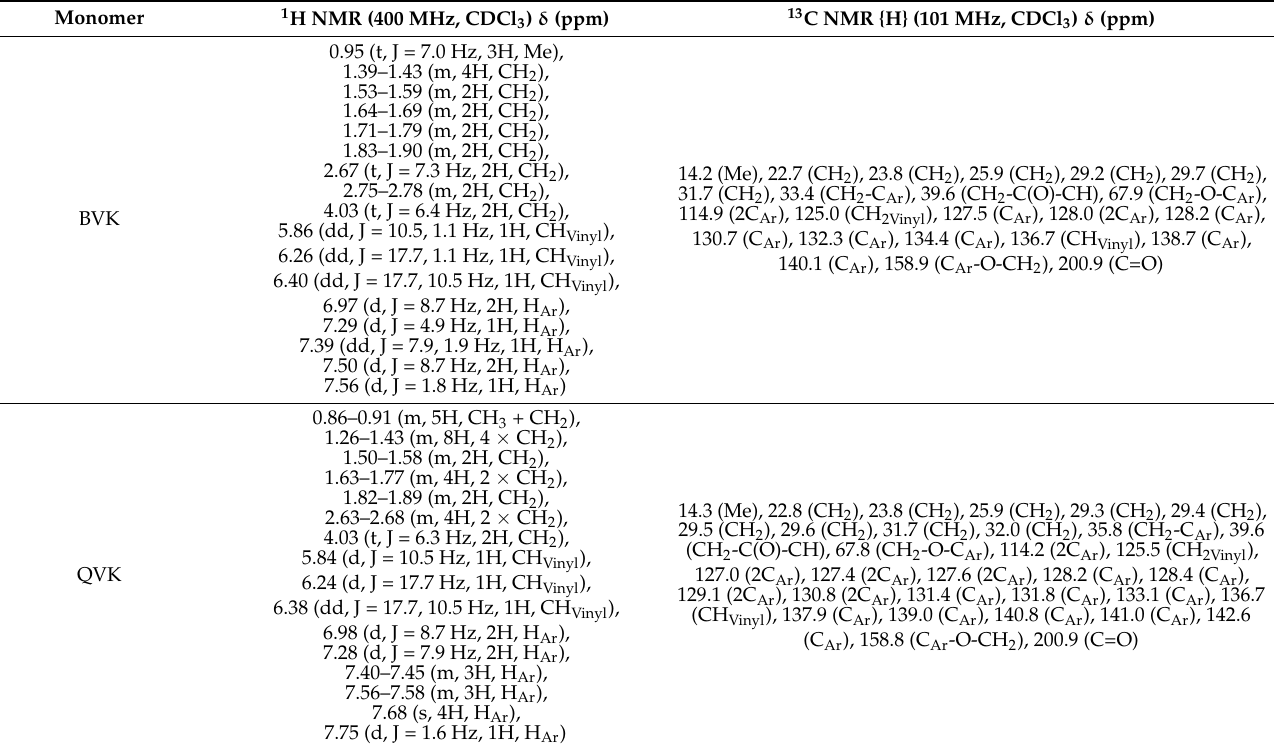
Table 1. The assignment of the signals in 1 H and 13 C NMR spectra of TVK , BVK , and QVK .